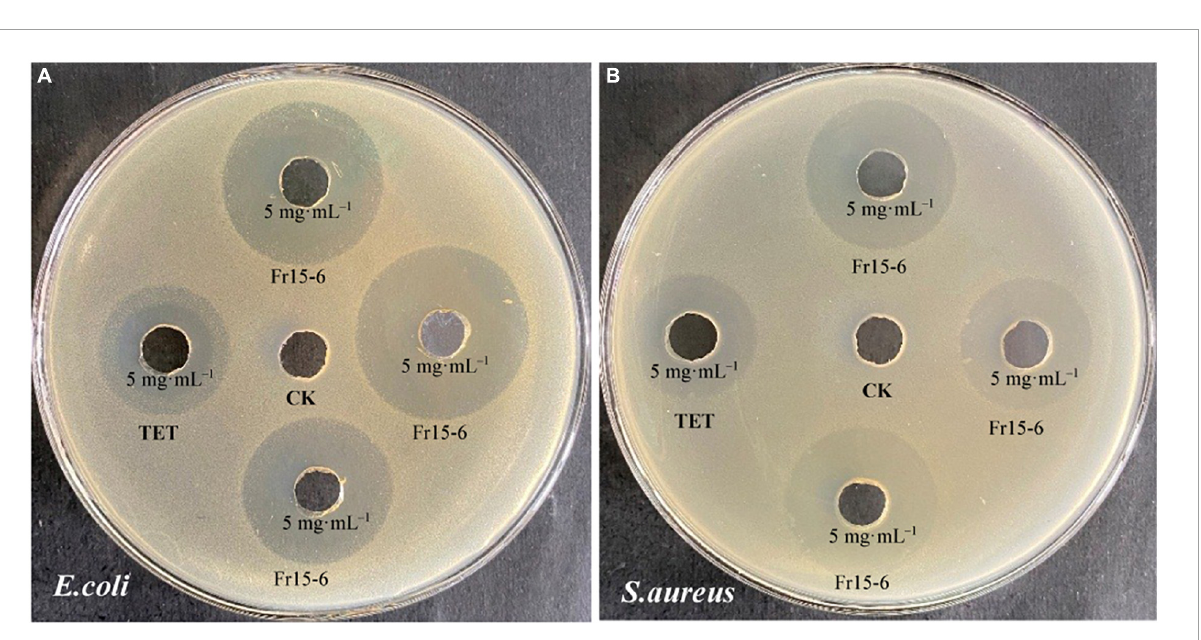
FIGURE5 Antimicrobial activity of the monomer component (Fr 15 - 6 ) isolated from the ethyl acetate (EA) crude extract of Penicillium macrosclerotiorum 1151# against Escherichia coli (A) and Staphylococcus aureus (B) by agar well diffusion method. Dimethyl sulfoxide (DMSO) was used as the blank control (CK), and the tetracycline (TET) as positive control. The concentration of all samples was 5 mg ml - 1 . The sample of the monomer component (Fr 15 - 6 ) was repeated for three wells in each Petri-dish